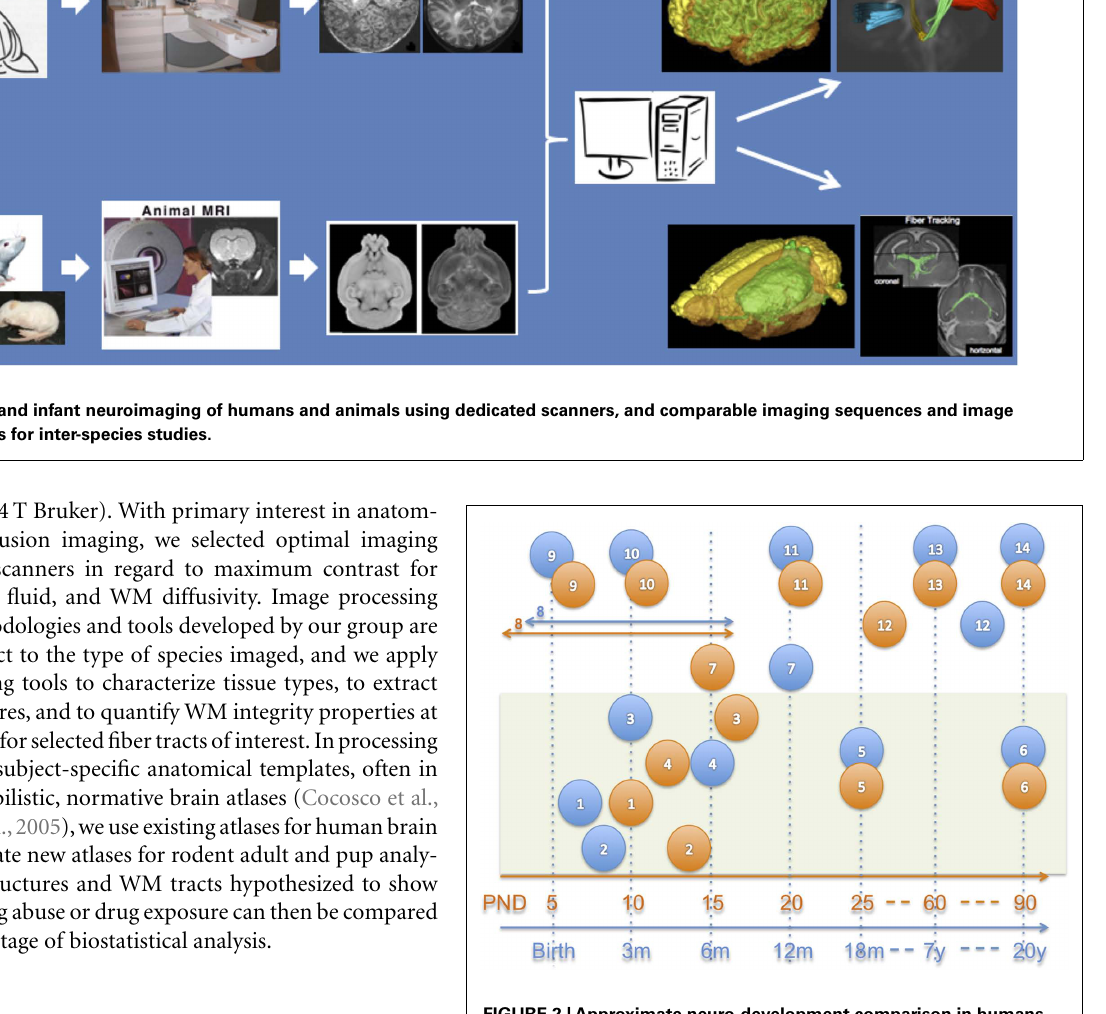
FIGURE 2 |Approximate neuro-development comparison in humans (blue) and rats (orange;Watson et al., 2006). 1–6 = myelination, 1 = myelination onset internal capsule, 2 = onset olfactory tract, 3 = onset anterior commissure, 4 = onset fornix, 5 = 50% myelination of corpus callosum, 6 = mature myelination, 7 = 50% cerebellum size, 8 = peak synaptogenesis period, 9 = maximum brain growth velocity (peak), 10 = cortical dominance established, 11 = mature cerebral metabolism, 12 = adult pattern of slow wave and REM sleep, 13 = adult brain weight, 14 = mature prefrontal